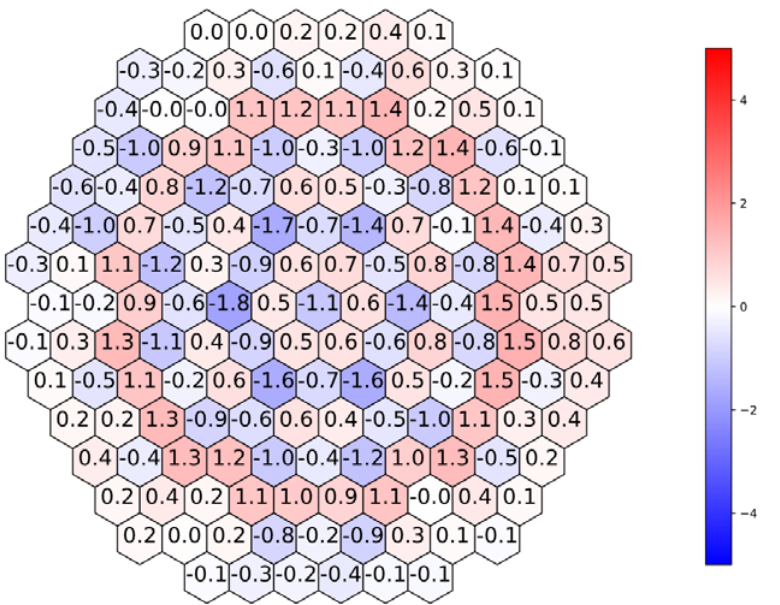
Figure 5: Relative assembly power differences between PARCS and